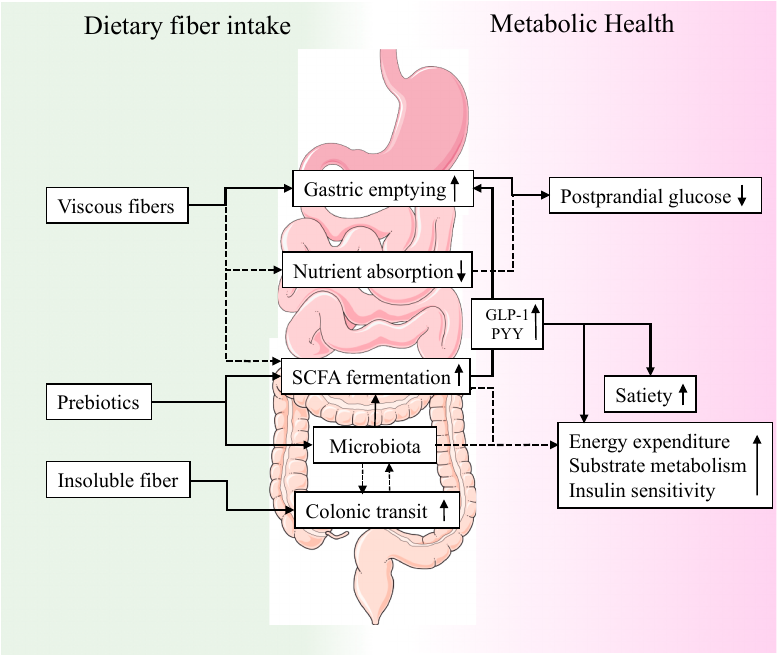
Figure 1. The complex relationship between dietary fiber intake, the gastrointestinal tract and host metabolism. Viscous fibers increase gastric emptying rate, may inhibit nutrient absorption and contribute to SCFA fermentation. These effects may lead to a reduced postprandial glucose appearance and an increased release of incretin and satiety-stimulating hormones (GLP-1, PYY), which might influence energy intake and peripheral tissue metabolism. Prebiotics modulate microbiota composition and SCFA production thereby affecting energy homeostasis and insulin sensitivity. Insoluble fibers are most effective in increasing colonic transit time thereby possibly affecting microbiota composition, and vice versa microbial metabolites may stimulate colonic motility. Solid lines indicate well-studied effects of dietary fiber, dashed line indicate more controversial findings. Abbreviations: SCFA short-chain fatty acids; GLP-1 glucagon-like peptide 1; PYY peptide